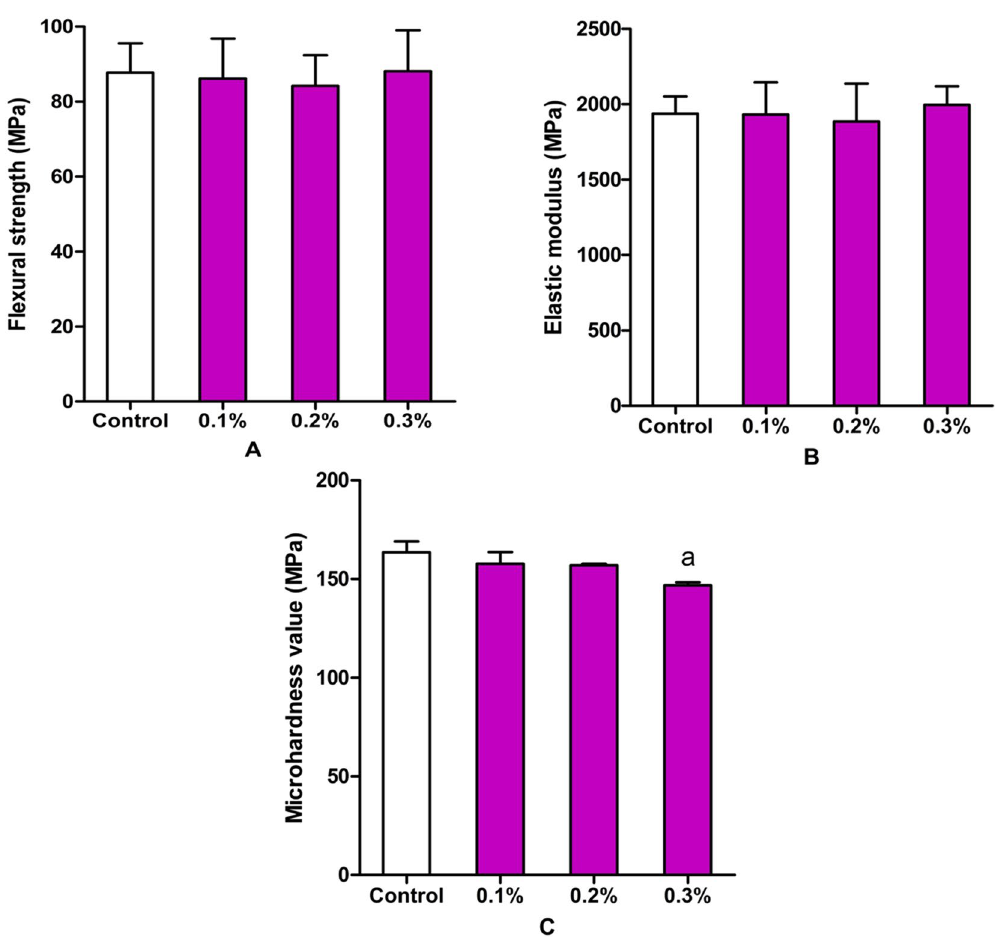
Figure 10. Mechanical properties of PMMA resin with or without AgBr/NPVP. ( A ) FS. ( B ) FM. ( C ) Vickers microhardness value. The data are presented as the mean ± SD (n = 9). “a” represents the significant difference (P < 0.05) with the other